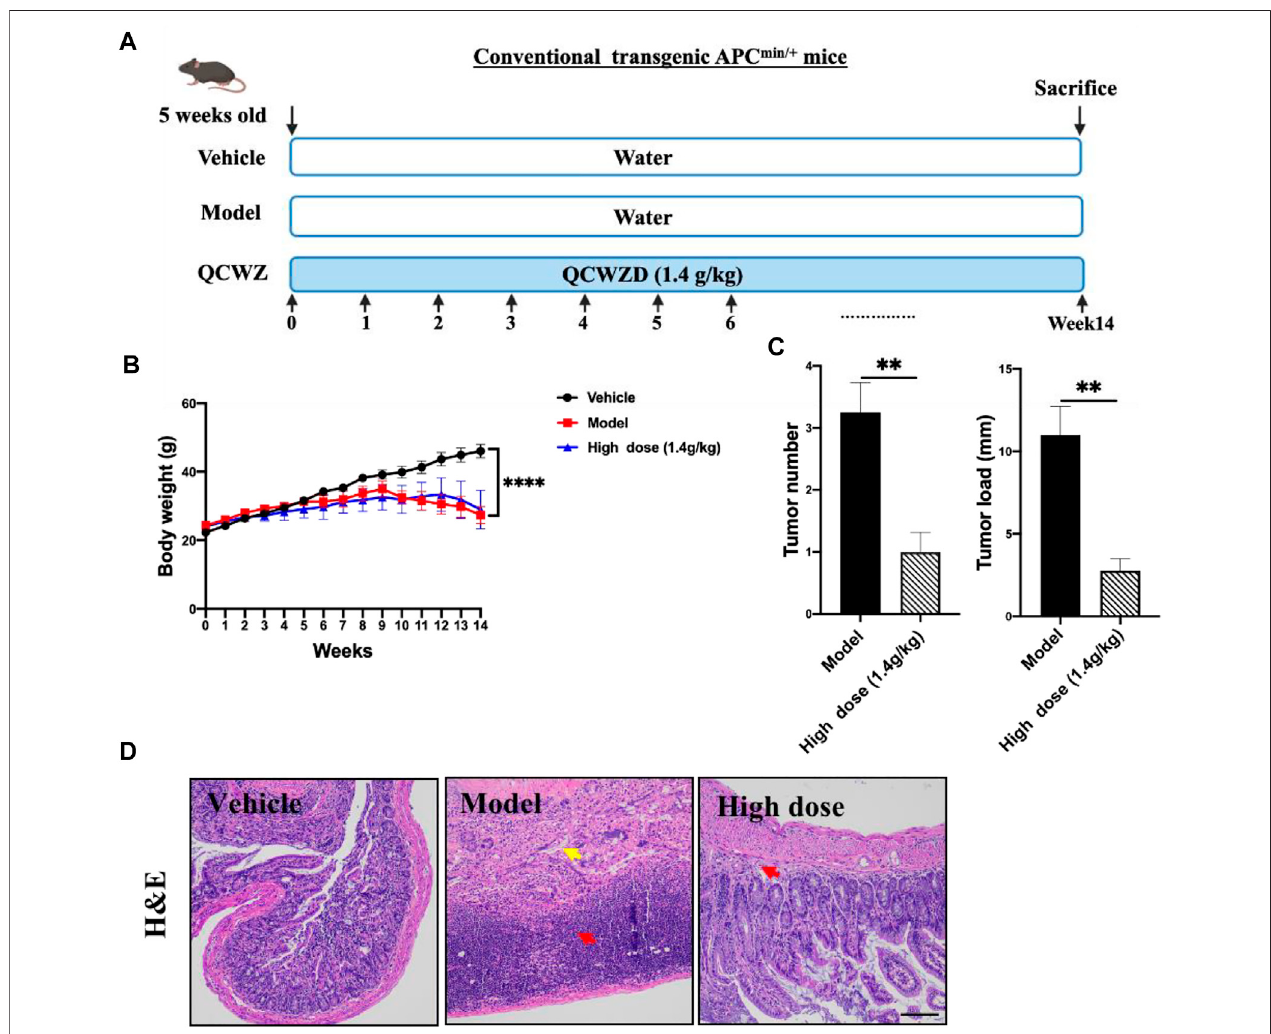
FIGURE5| PreventiveeffectsofQCWZDinApc min/+ mice. (A) TheApc min/+ mousemodel. (B) Measuredbodyweightand (C) tumorload. (D) RepresentativeH&E- stainedcolorectum sections (magni fi cation: ×200). Red arrow: in fl ammatorycell in fi ltration,yellow arrow: lymphocytic in fi ltration; High dose: 1.4 g/kg, ** p < 0.01, **** p <